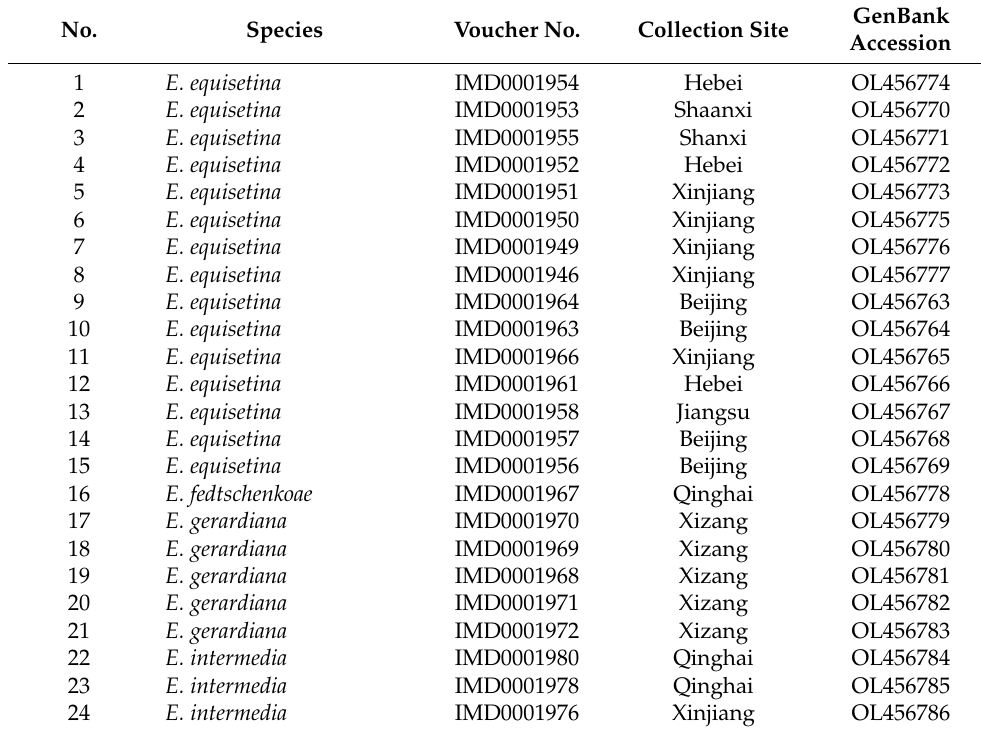
Table 1. Information of the Ephedra samples in this study.